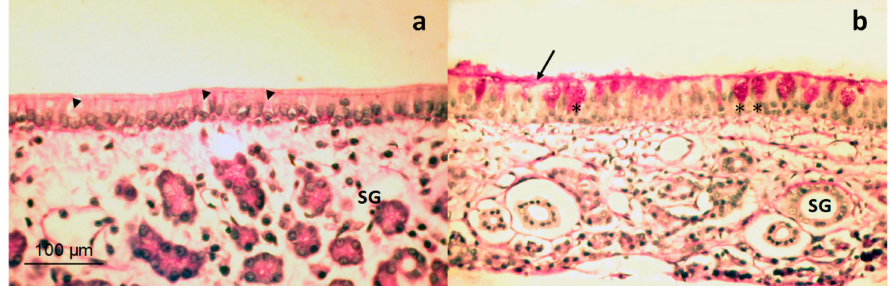
Figure 6. Histology of nasal mucosa (respiratory region) of rabbits treated with three-fold dose. Control mucosa ( a ) without secretory activity and B group mucosa (three-fold dose) administrated animals, ( b ) stained with PAS at 200 × magnification. Asterisks indicate goblet cells full of mucus; arrow indicates mucus layer; and arrow heads indicate empty goblet cells. SG = serous gland. Scale bar = 100 µ